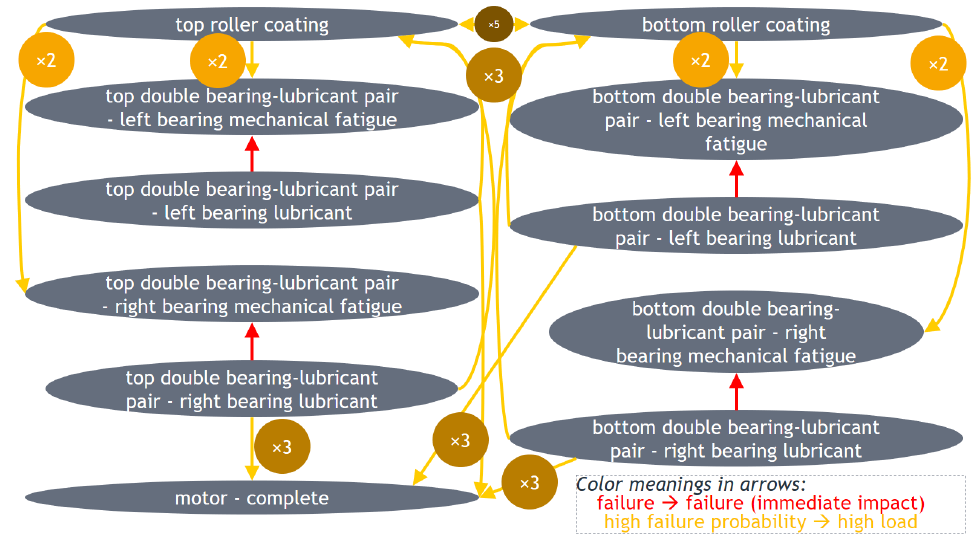
Figure 13. Failure-type dependencies and load multipliers for the bleaching machine (ZORLUTEKS). KPI types considered: economic, energy, other environmental (water, steam, material) Measurement units of